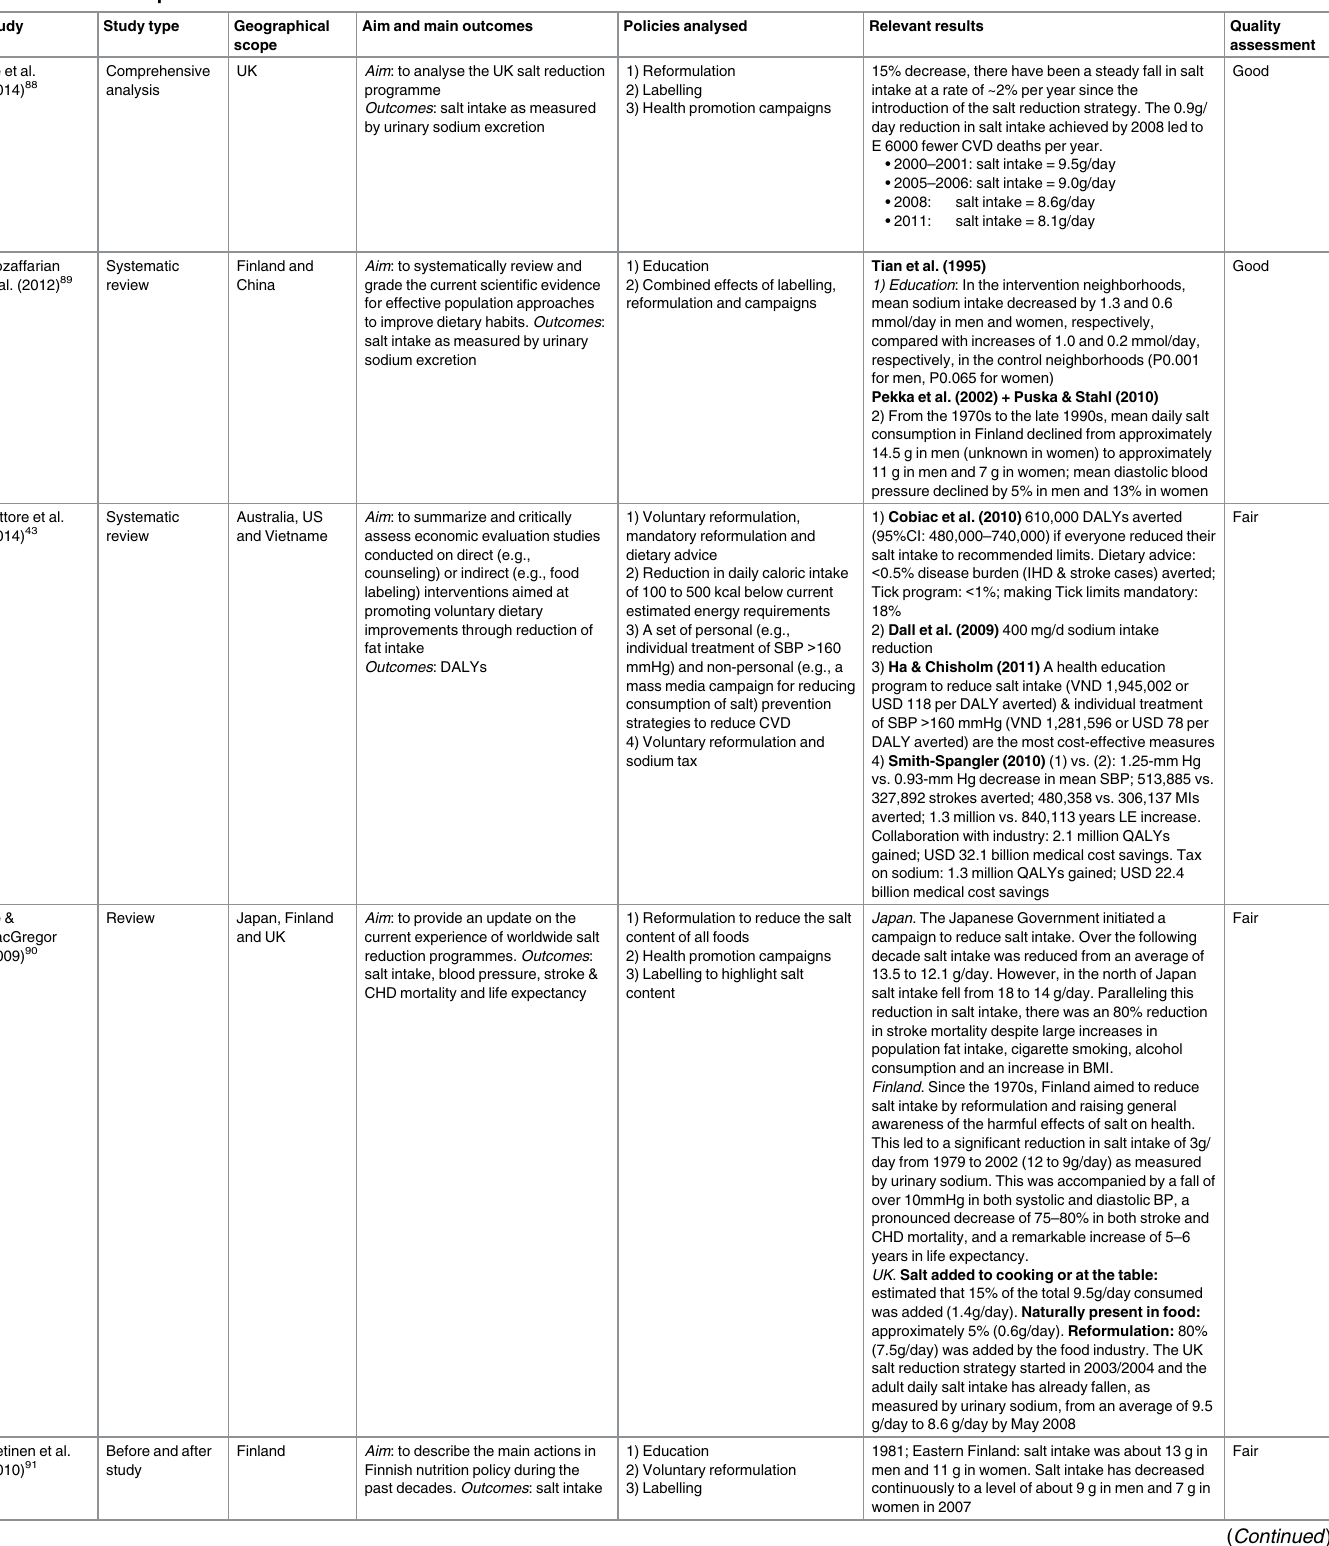
Table 9. Multi-component